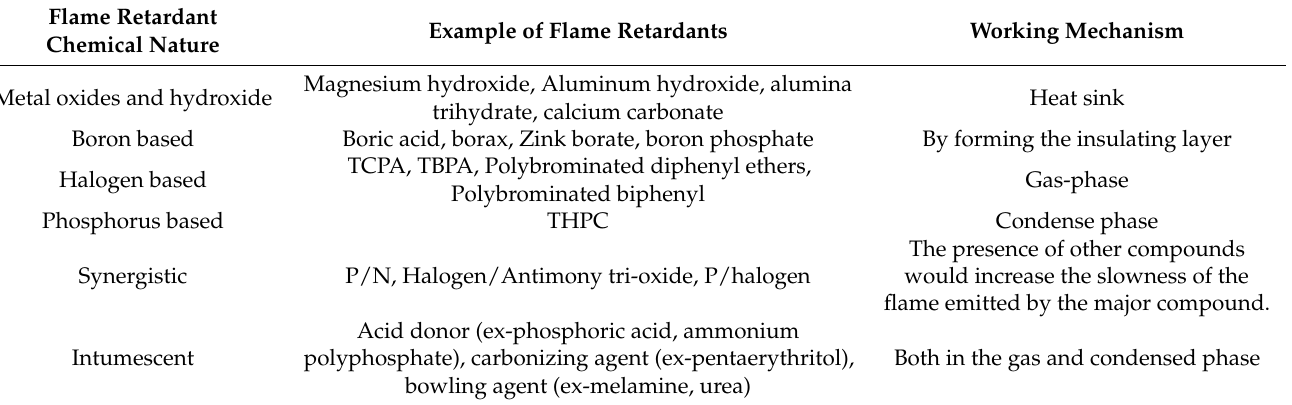
Table 1. Various metallic fillers use for fire retardant applications